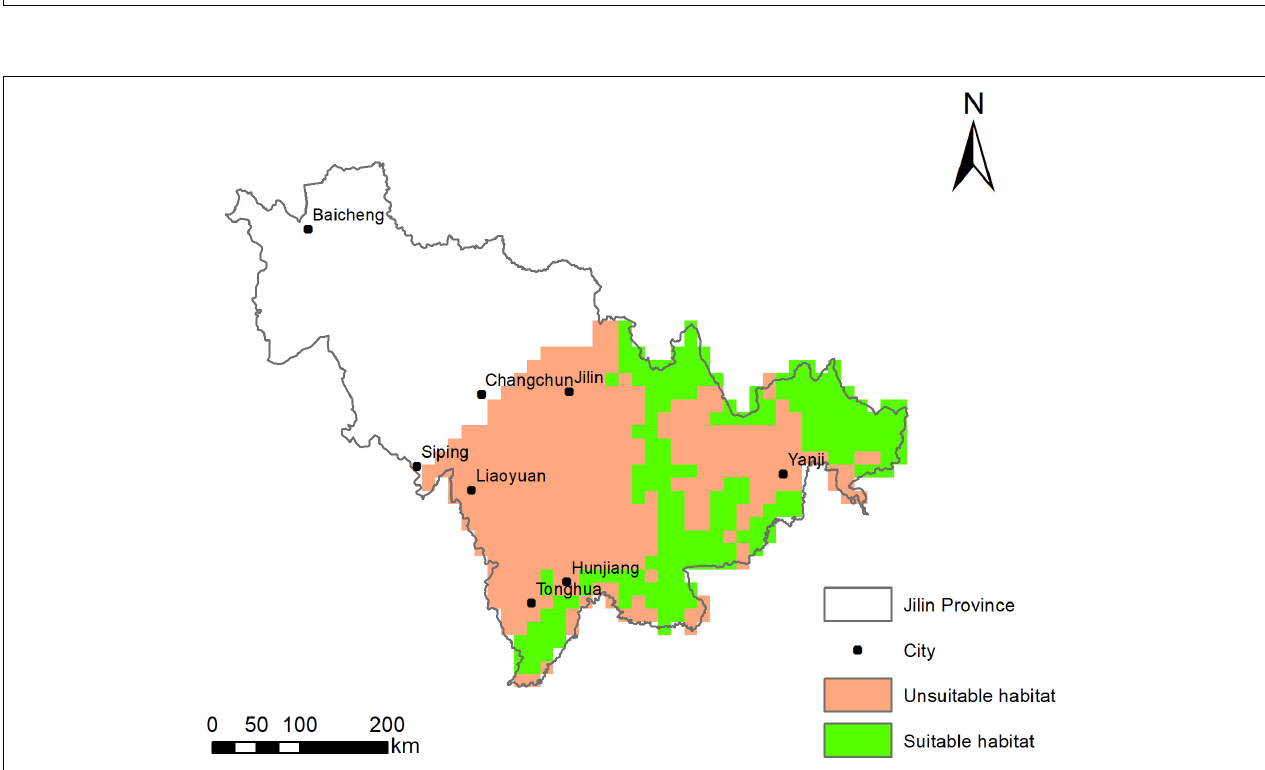
FIGURE 5 | Suitable habitat of the Asiatic Black Bear in Jilin